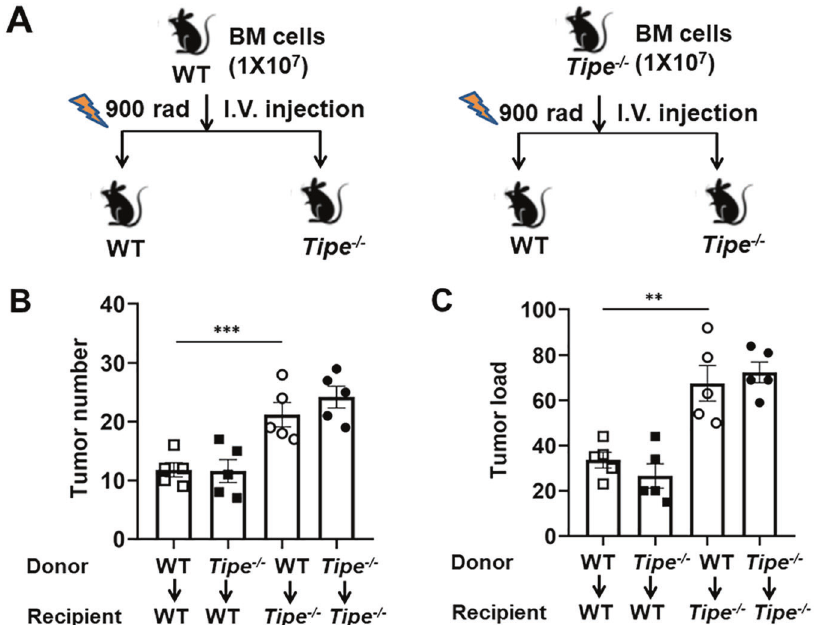
Fig. 6 Restoration of hematopoietic TIPE fails to rescue Tipe − / − AOM/DSS phenotype. Bone marrow transplants were performed on WT and Tipe − / − mice as indicated. A Schematic of experimental design. WT and Tipe − / − mice were irradiated, transferred with WT or Tipe − / − bone marrow cells, allowed to recover 8 weeks, and followed by AOM/DSS protocol. B , C Colon tumor number ( B ) and tumor load ( C ) of BM- transplanted WT and Tipe − / − as described in ( A ) ( n = 5 per group). Data are representative of two independent experiments. Data are presented as mean ± SEM and are representative of two independent experiments. Student ’ s t test ( B , C ), ** p < 0.01, *** p < 0.001.